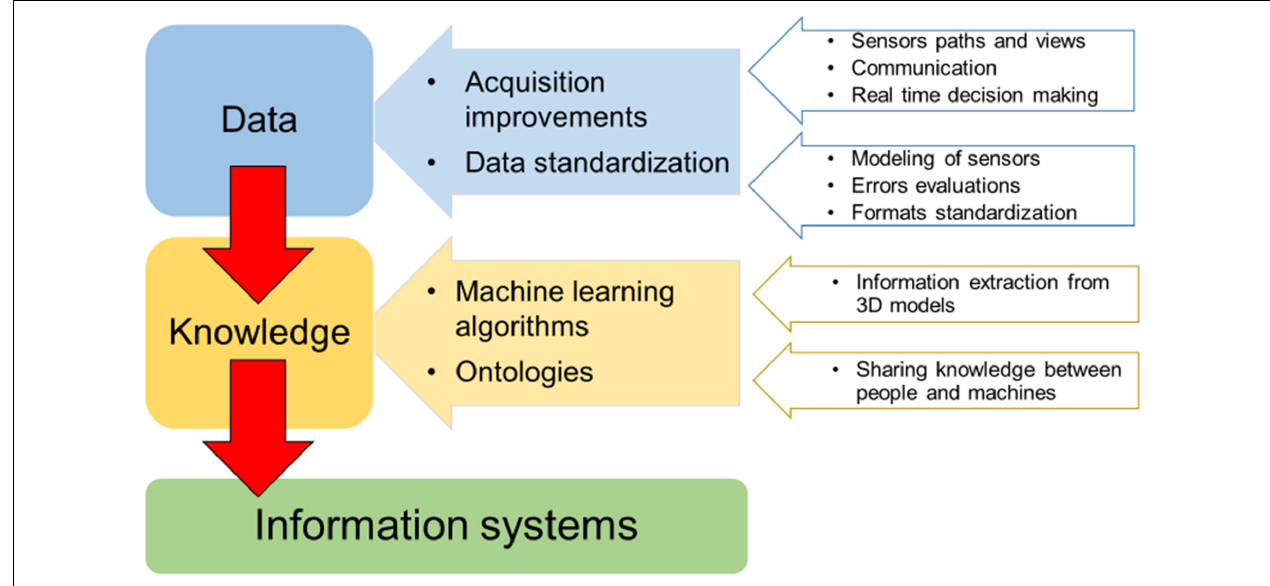
FIGURE 2 | Main needs and gaps for 3D complexity investigations of underwater marine animal forests. The generation of exchangeable knowledge (information system) starts from standardized